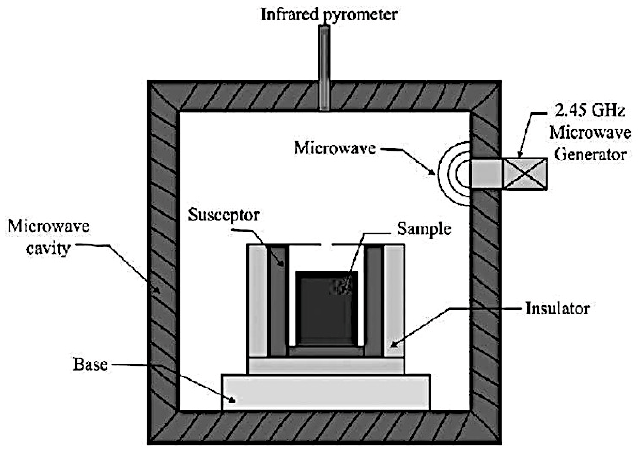
Figure 2. Schematic of microwave sintering furnace [32]. Microwave sintering has a significant advantage over other methods. Thermal conduc- tivity includes heat transfer modes such as radiation and convection followed by conduction in conventional sintering. Thermal equilibrium and consolidation of the materials take a long time in traditional sintering. It is important to note that in microwave heating, the microwave field is absorbed first before the electromagnetic energy is converted into thermal heat. No heat transfer modes were used in this procedure because the heating was instantaneous and highly dependent on the material’s pace. When the heat is produced internally and delivered outward, it does not come from outside. Rather than heating from the outside in, the heating profile is reversed from the inside out. Microwave heating is much faster than traditional methods because it uses energy conversion rather than transmission to heat the material. Figure 3 shows heating profiles of conventional and microwave